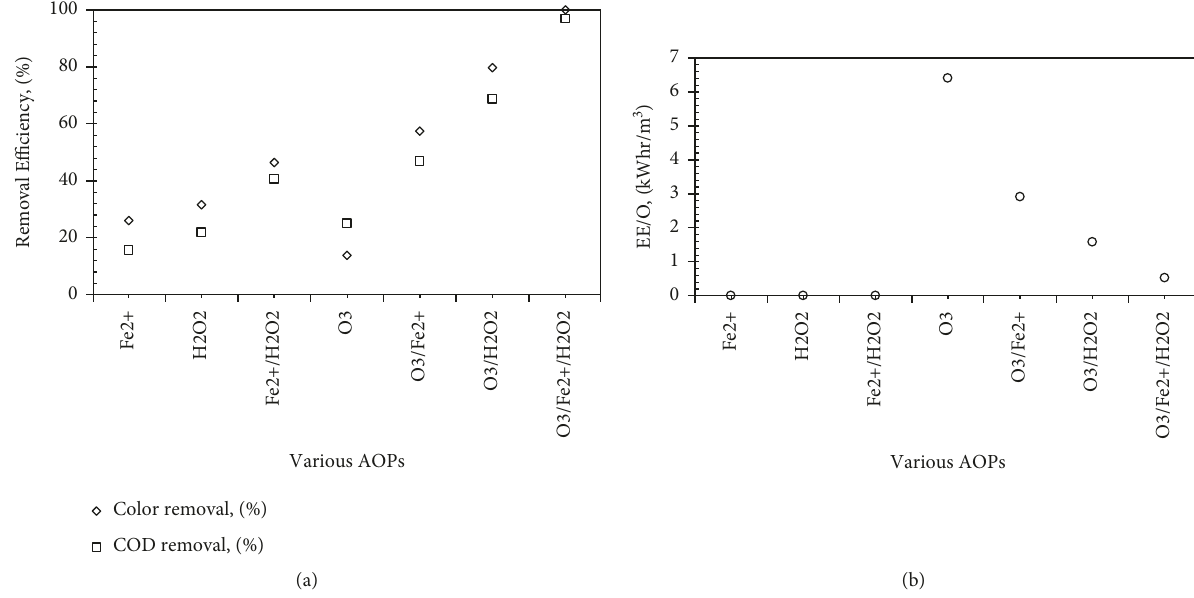
Figure 2: Comparison of various AOPs such as Fe 2+ , H COD removal and (b) EE/O (experimental conditions: COD–1600 mg/L; reaction time–4 h; O3 flow rate and production–20 LPM and 4g/h; H 2 O 2 –100mM; Fe 2+ –20mM; and pH–6).